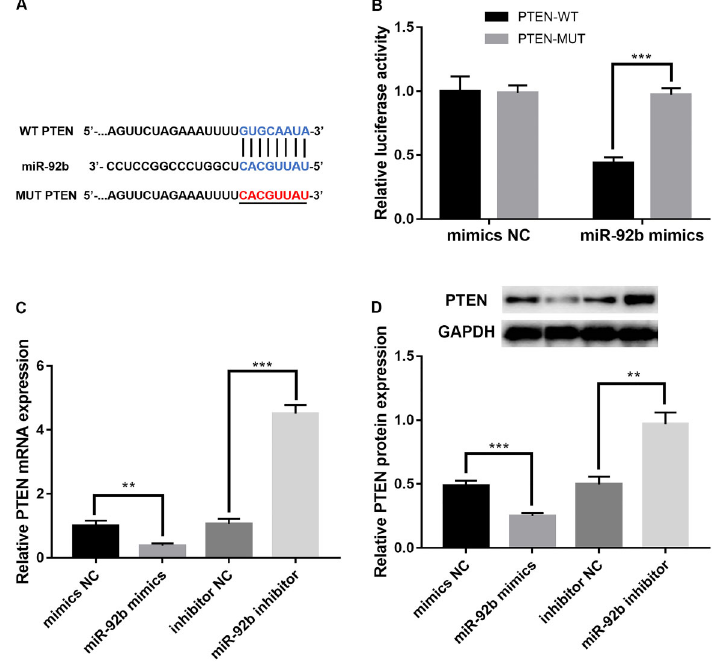
Figure 3. PTEN is a target of miR-92b. A , Binding site of miR-92b is located on PTEN mRNA 3 0 UTR. B , Relative luciferase activities in HepG2/SOR cells co-transfected with miR-92b mimics and luciferase reporters containing PTEN-WT (wild type) or PTEN-MUT (mutant) transcript. C , The mRNA expression and ( D ) PTEN protein expression was measured using qRT-PCR and western blot in HepG2/SOR cells at different transfections. Data are reported as means ± SD. **P o 0.01, ***P o 0.001 (ANOVA and Student ’ s t -test). NC: negative